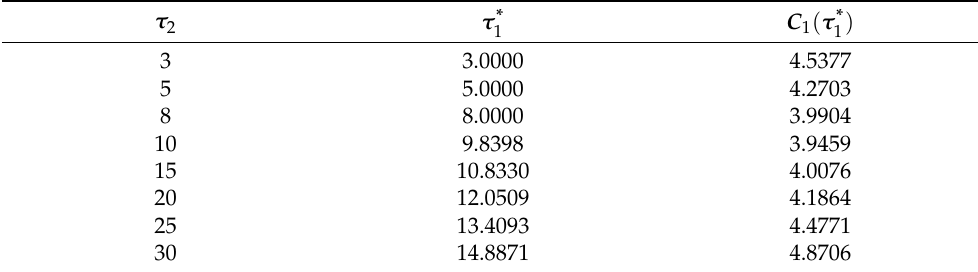
) obtained for different values τ and C 1 ( τ ∗ 1 1